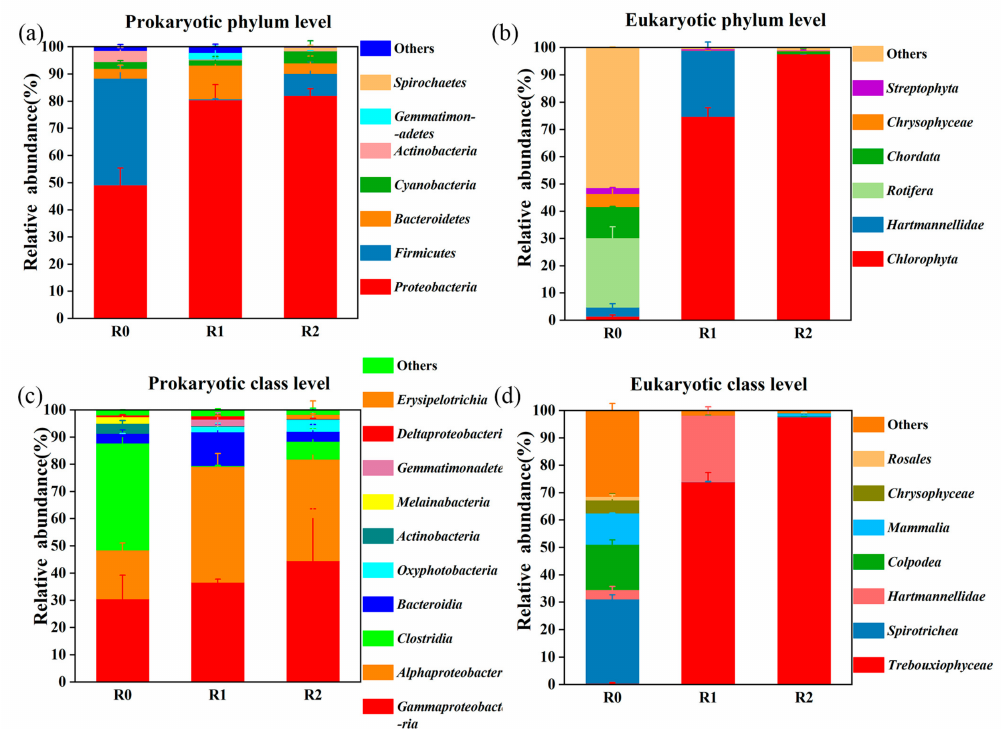
Figure 3. Microbial community of microalgal-bacterial granular sludge at phylum and class levels (>1% relative abundance). ( a ) prokaryotic phylum; ( b ) eukaryotic phylum; ( c ) prokaryotic class; ( d ) eukaryotic class. (R0: Initial; R1: Aeration; R2: